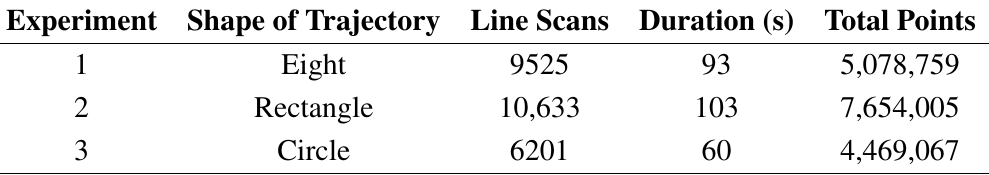
Table 1. Properties of the indoor datasets evaluated in this